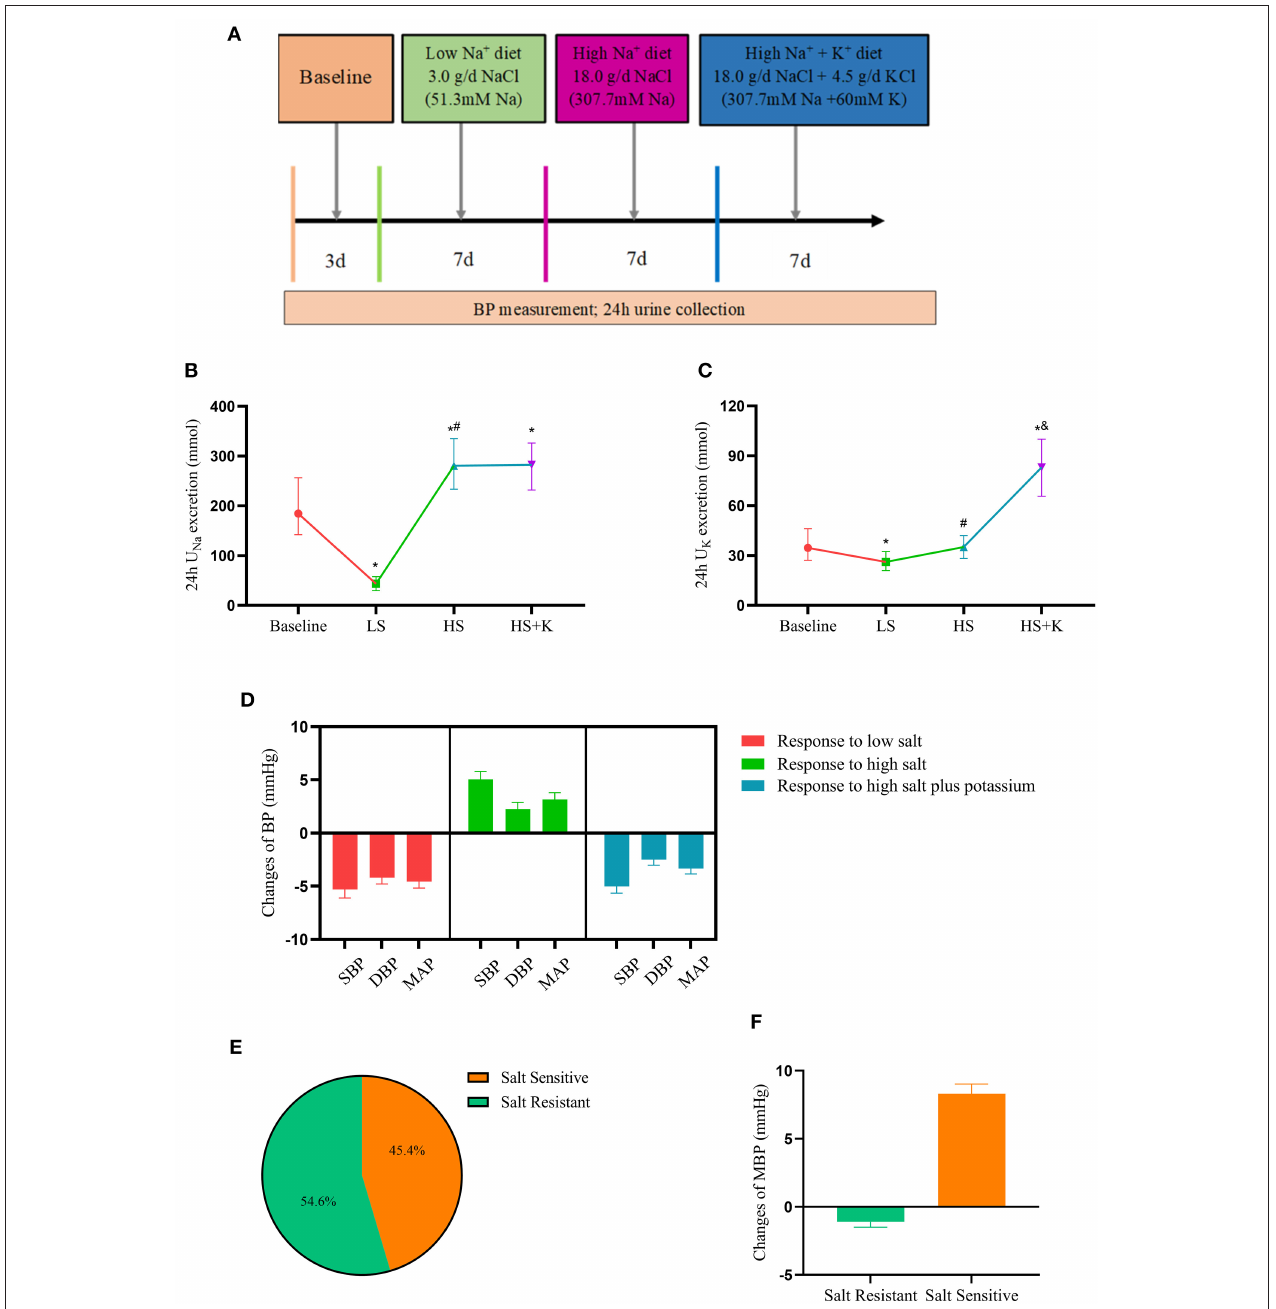
FIGURE 1 | Dietary interventions in subjects-chronic salt loading trial. (A) The protocol of dietary intervention; (B) The 24h urinary sodium excretion in participants during the dietary intervention; (C) The 24h urinary potassium excretion in participants during the dietary intervention; (D) The responses of blood pressure to dietary intervention; (E) The proportion of different salt sensitive phenotypes in the participants; (F) The responses of MAP to high salt intervention in salt-sensitive and salt-resistant participants. BP, blood pressure; DBP, diastolic blood pressure; MAP, mean arterial pressure; SBP, systolic blood pressure; HS, high salt intervention; LS, low salt intervention; HS + K, high salt plus potassium intervention. * P < 0.05 vs. baseline; # P < 0.05, high salt diet vs. low salt diet; & P < 0.05, high salt plus potassium diet vs. high-salt diet.